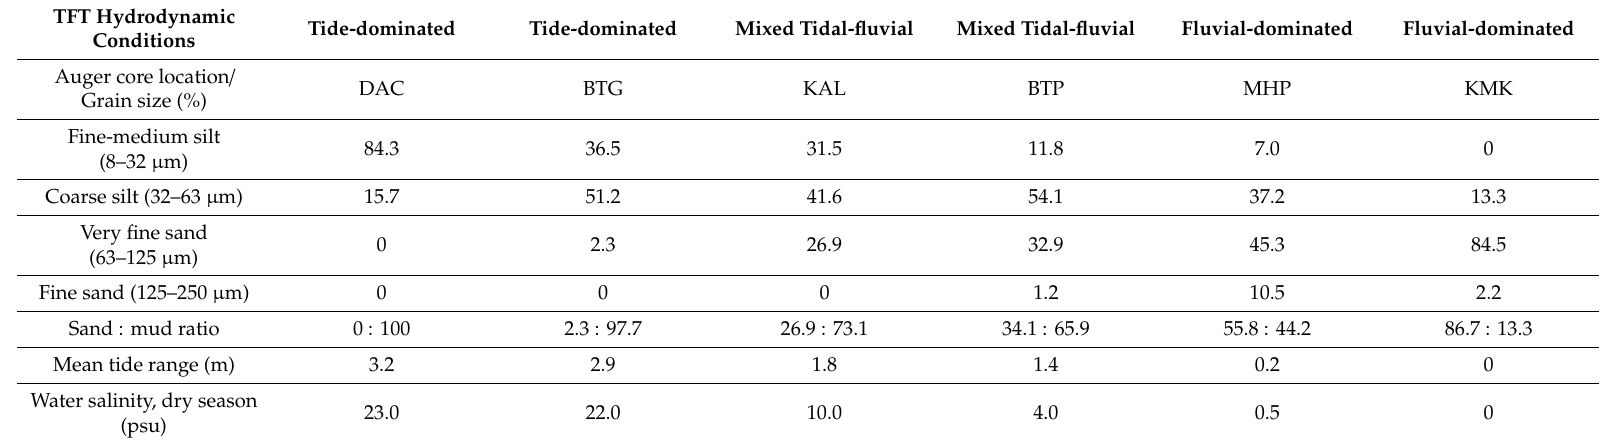
Table 1. Median grain size proportions for auger core locations and depositional zones. Note that changes in sand (and mud) content are particularly pronounced between BTG and KAL (across the backwater), as well as between MHP and KMK (near the limit of tidal influence). Mean tide ranges, originally reported by EGIS (2000) and BIWTA (2019), take into account neap / spring variation and seasonal conditions. Water salinity values for the dry season were reported by Winterwerp and Giardino (2012); water salinity is negligible for all sites during the monsoon